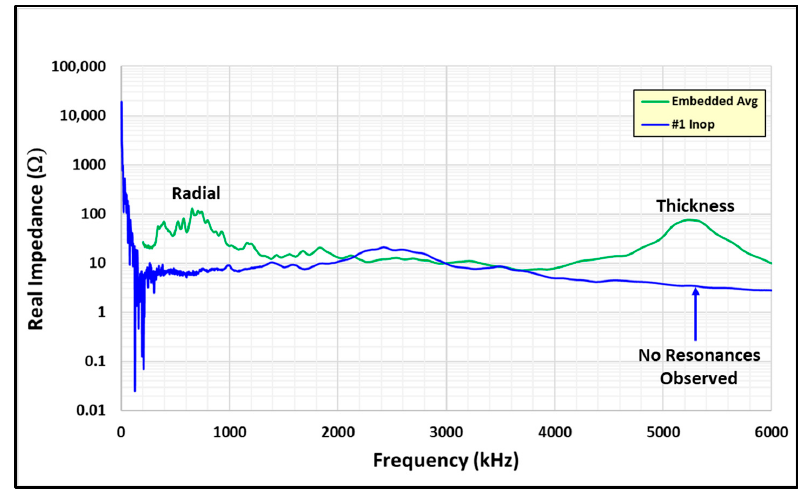
Figure 14. Inoperable embedded sensor #1 impedance response.